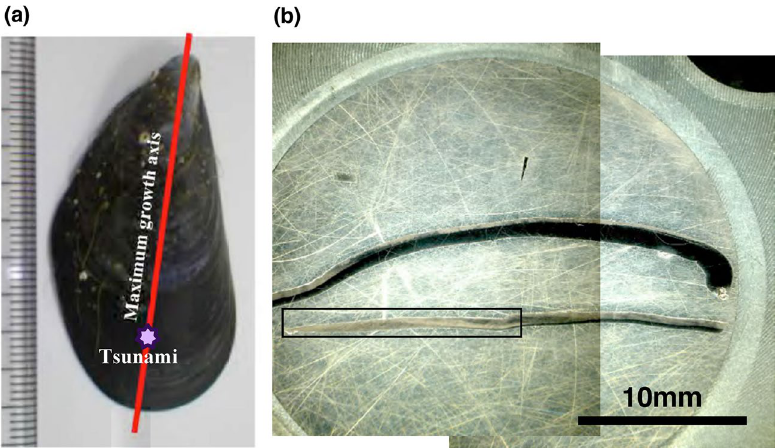
Figure 1. Photograph of the cut section and age-model of the mussel shell. ( a ) Photograph of Mytilus galloprovincialis collected at the Otsuchi bay, on the Pacific coast of northeastern Japan. A red line and purple star indicate the maximum growth axis and the approximate position of the great tsunami. ( b ) The cutting section mounted in a 2.54 cm diameter Araldite resin disk. Digital microscopy of the section stained by Mutvei’s solution for the squared area was shown in Figure